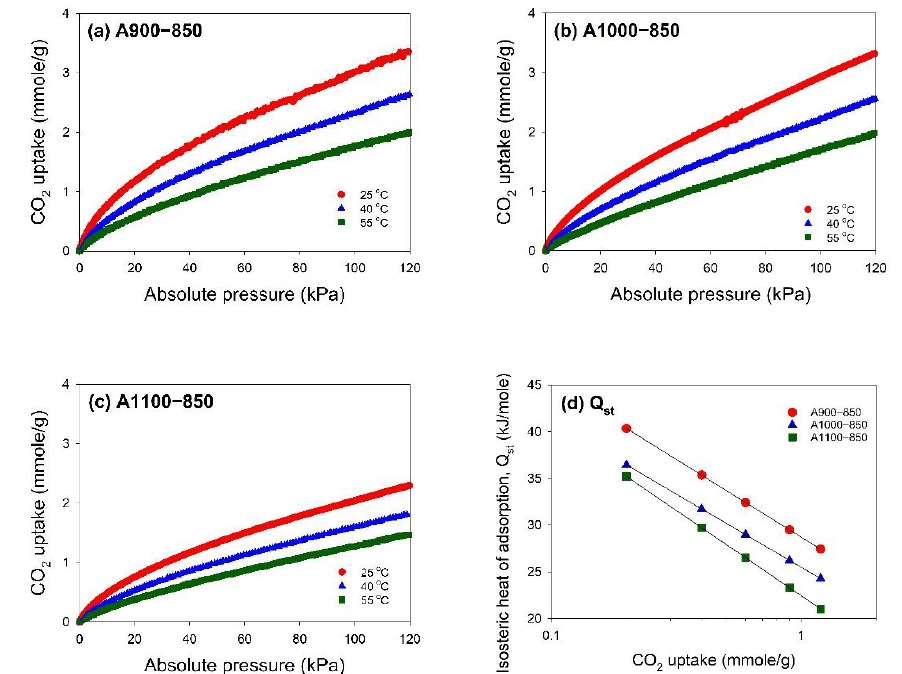
Figure 8. Adsorption isotherms of CO 2 of the samples: ( a ) A900 − 850; ( b ) A1000 − 850; ( c ) A1100 − 850; and ( d ) the isosteric heat of adsorption of CO 2 on the